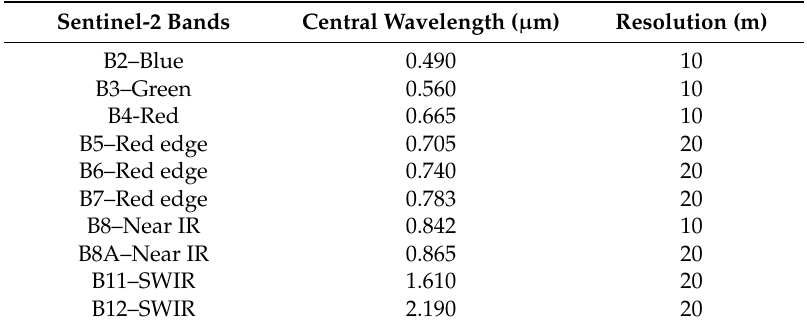
Table 3. Sentinel-2 bands with 10 m or 20 m resolution. Near IR is Near Infra-Red and SWIR is Short wave